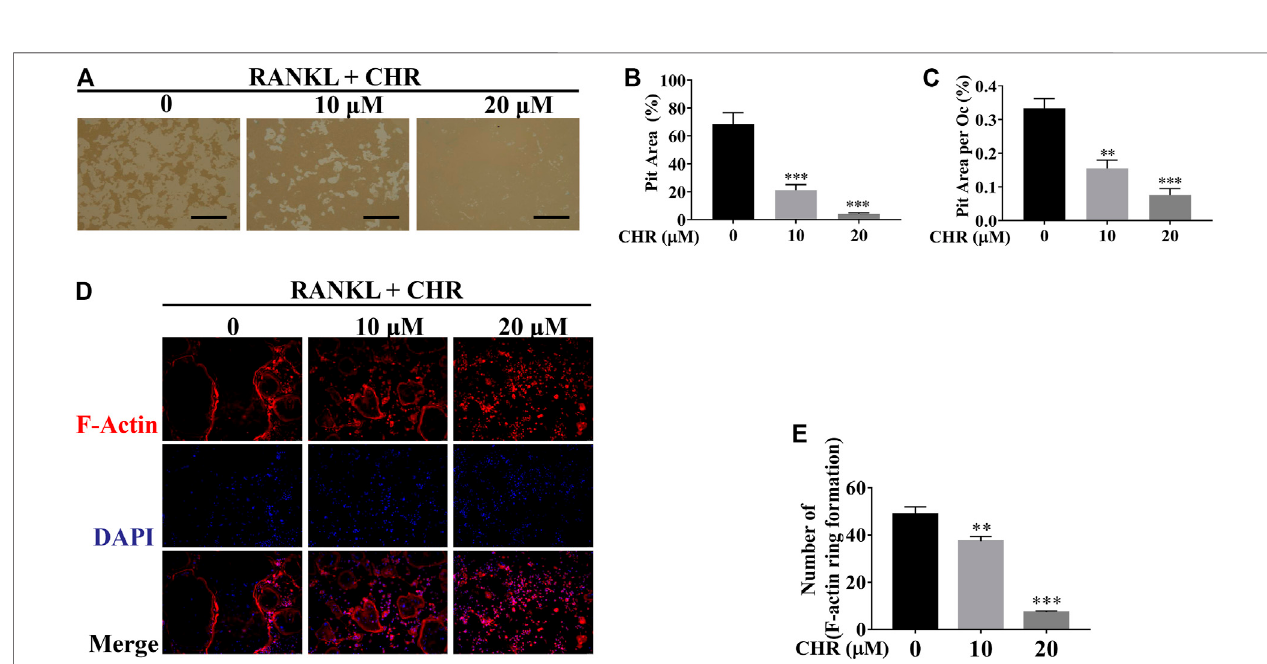
FIGURE 3 | CHR suppressed OC bone resorption and F-actin belts formation. (A) Mature OCs were seeded onto hydroxyapatite-coated plates and treated with indicated concentrations of CHR for 48 h. Attached cells were removed and micrographs of bone resorption pits (Magni fi cation = ×100; scale bar = 100 µM). (B,C) ImageJwasused toquantifythepercentageofabsorptionpitareaoccupiedbyeachosteoclastand thetotalabsorptionpitarea.Thedatapresentedisarepresentative ofthreeindependentexperiments andexpressedasmean±SD. (D) CHRsuppressed RANKL-inducedF-actinbeltsformation.MurineBMMcellswerestimulated with RANKL and M-CSF and treated with CHR (10 and 20 μ M) as previously described. OCs formed were fi xed and stained for F-actin and nuclei with Rhodamine- conjugated phalloidin and DAPI, respectively, and images captured using laser scanning confocal microscopy. The data presented is a representative of three independent experiments and expressed as mean ± SD. (E) The numbers of OCs based on F-actin belts formation were quanti fi ed (** p < 0.01, *** p < 0.001 vs RANKL- treated controls.)